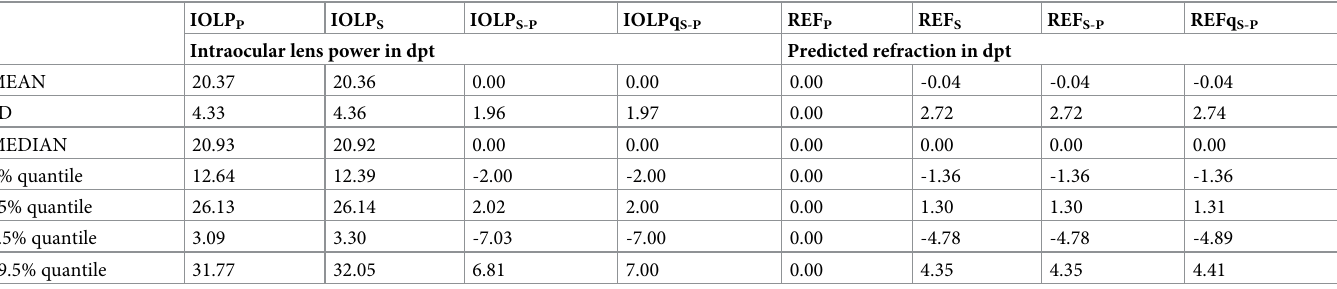
Table 3. Left side: Descriptive data of the lens power calculated with the Castrop formula for emmetropia based on the primary eye biometry (IOLP P ) or the sec- ondary eye biometry (IOLP would be inserted (REF S ), together with the difference REF S-P = REF S -REF P and the difference REFq S-P = REFq S -REFq P for the ‘realistic case’ where the quantised lens IOLPq S derived from the secondary eye biometry is inserted instead of the quantised lens (IOLPq P ) derived from the primary eye biometry.